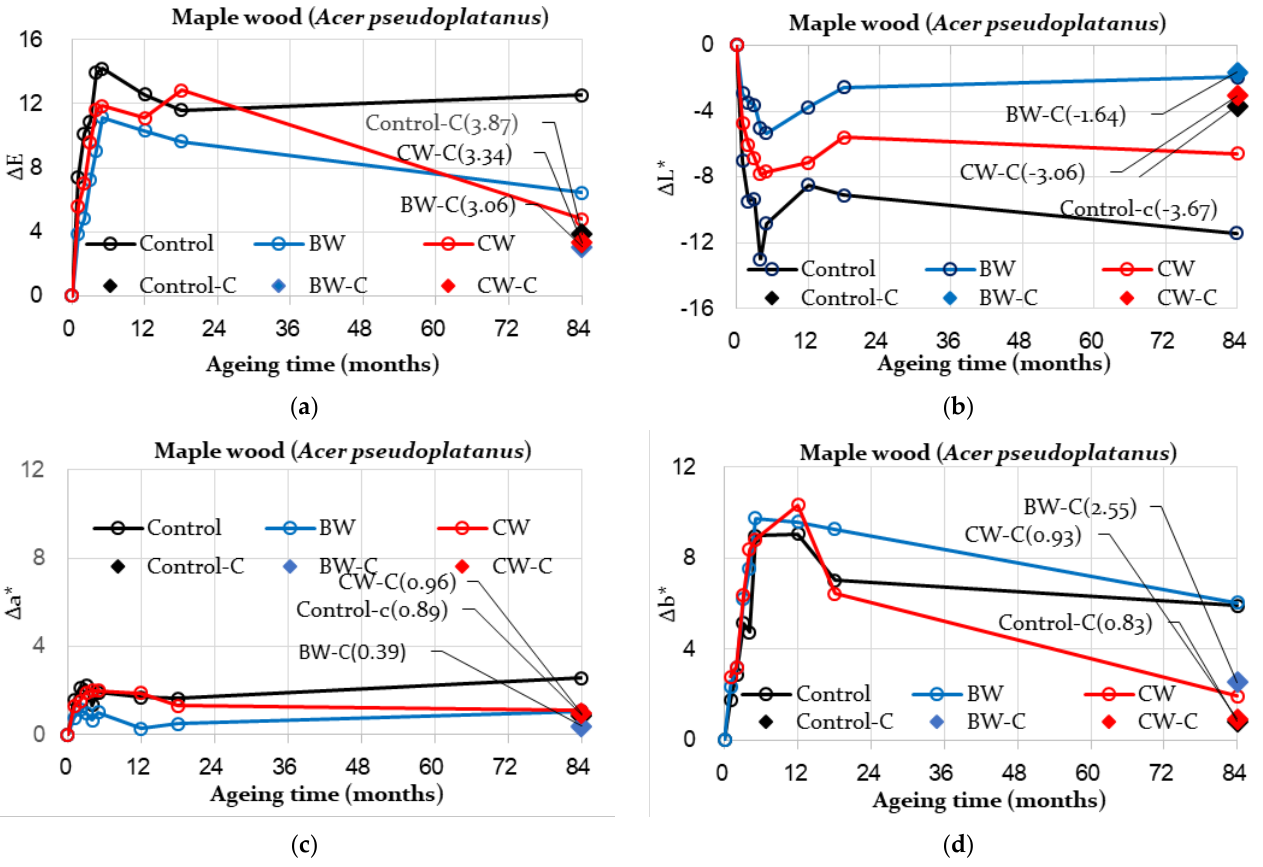
Figure 2. Colour changes of uncoated and coated European maple wood ( Acer pseudoplatanus ) samples during indoors natural ageing. ( a ). Global colour changes ( ∆ E); ( b ). Lightness changes ( ∆ L*); ( c ). Redness changes ( ∆ a*); ( d ). Yellowness changes ( ∆ b*). Codes ending with -C represent comparative data for the covered surfaces at the end of the test (7